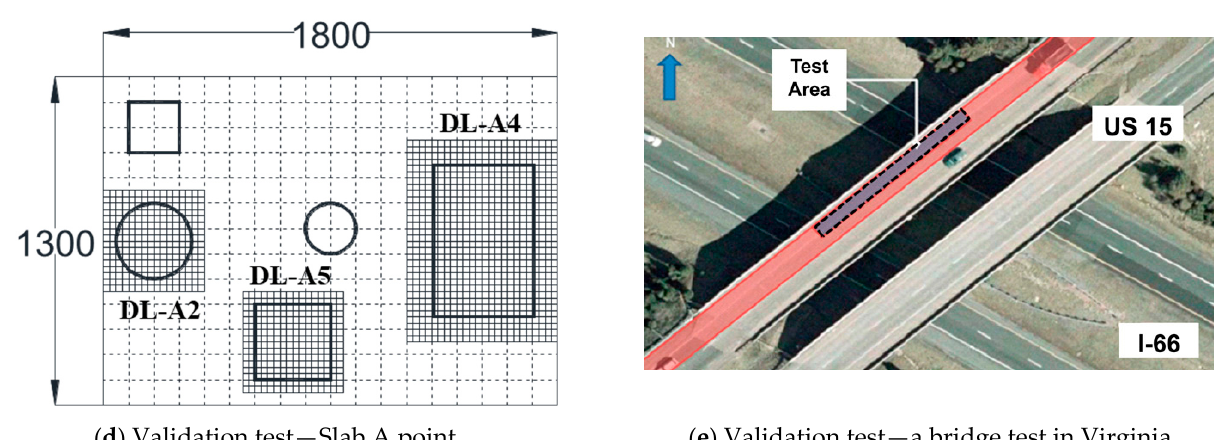
Figure 5. Test specimens for training and validation with SL and SSL. Table 1. Attributes of specimens depicting artificial defects used for the training and validation of SL and SSL models.